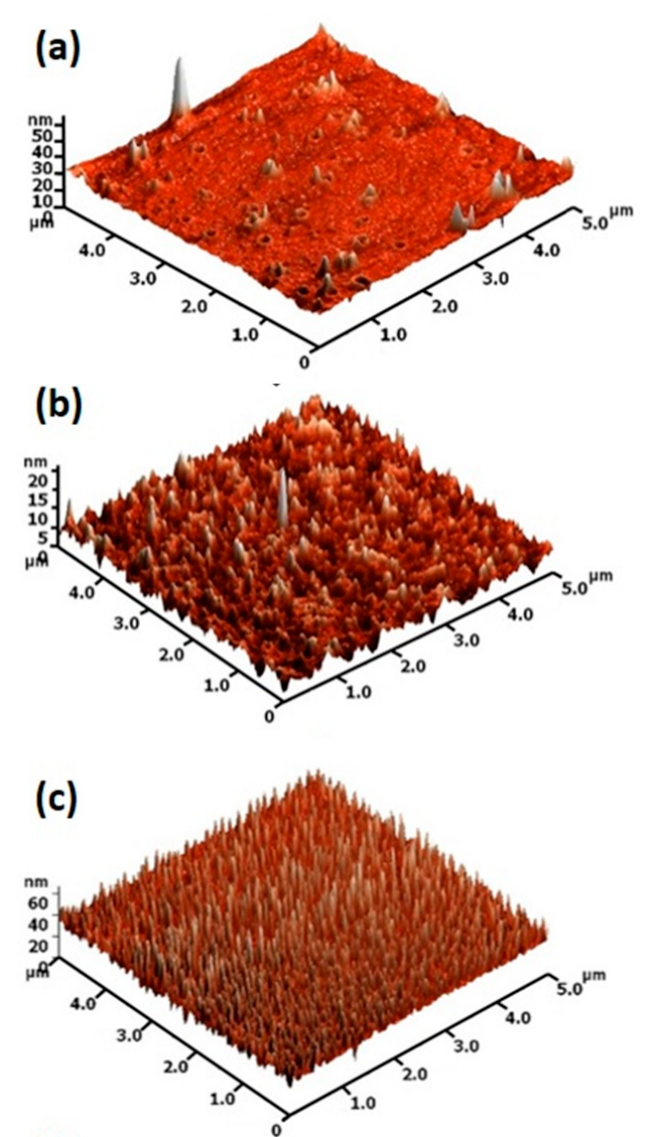
Figure 5. AFM surface morphology images of the TiO 2 thin film post ‐ annealed at a ) 400 °C, b ) 500 °C and c ) 600 °C.